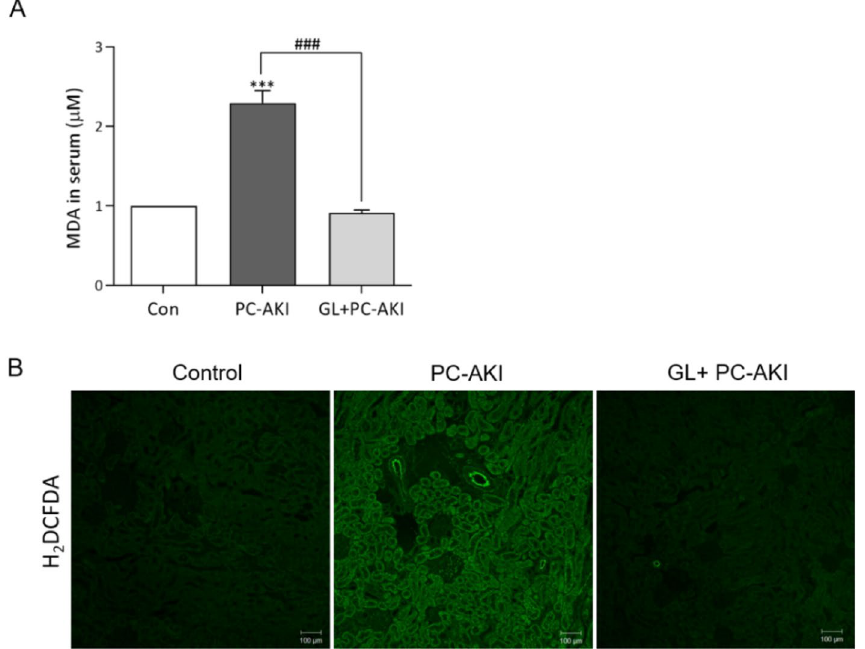
Figure 1. Glycyrrhizin attenuates oxidative stress. Oxidative stress was evaluated with MDA levels in the serum ( A ) and H 2 DCFDA staining in kidney tissue ( B ). Oxidative stress was significantly higher in the PC-AKI group compared to the controls, whereas it was mitigated in the PC-AKI with glycyrrhizin group. Magnification = 10X, Scale bar = 100 μm. Results were expressed as means ± SEMs. N = 8 for each group. Statistical significance: *** P < 0.001 Con vs PC-AKI, ### P < 0.001 PC-AKI vs GL + PC-AKI. Abbreviation: PC-AKI, post-contrast acute kidney injury; GL, glycyrrhizin; MDA,